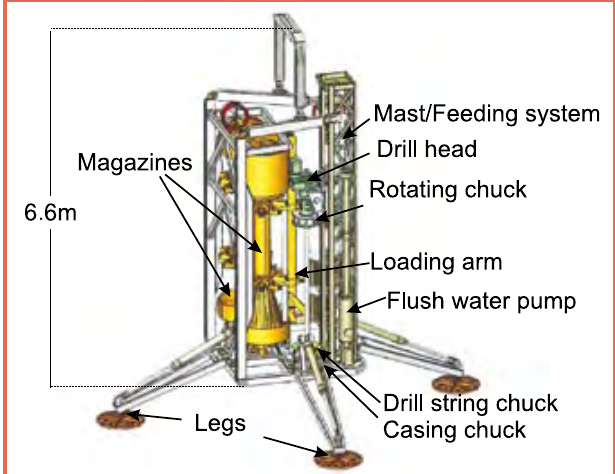
Figure 2. Overview of basic components of sea floor drill rig MeBo.